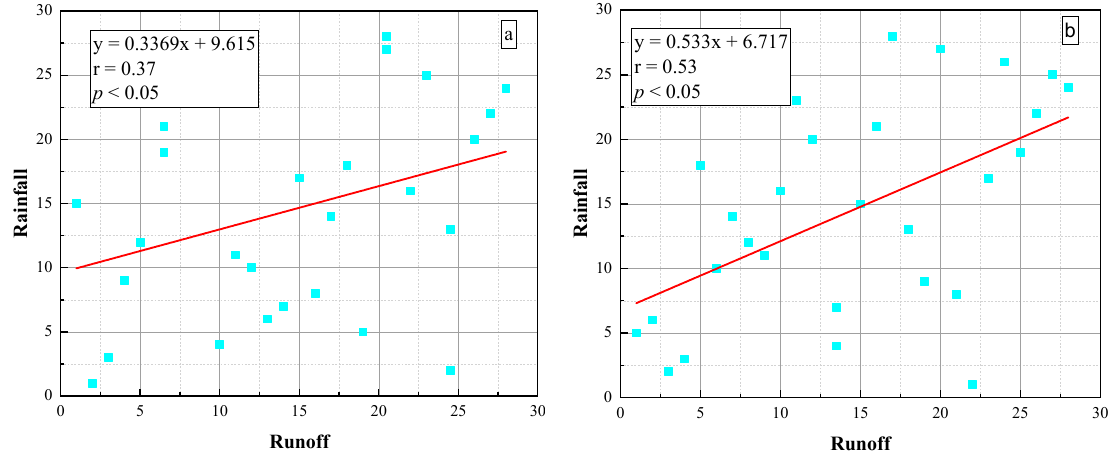
Figure 13. Spearman rank correlation coefficient for the rainfall and the runoff average annual data: ( a )—Novoselenginsk station, and ( b )—Mostovoi station. We also carried out the correlation tests for air temperature and precipitation over the past 50 years, and calculated the Spearman rank correlation coefficient of the average annual data for the two stations (Figure 14). At the Novoselenginsk station, the rank correlation coefficient showed a moderate positive relationship (0.45), and strong relationship at the Ulan-Ude station (0.65).